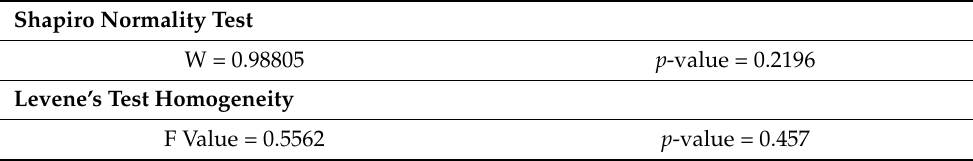
Table 7. Welch Test and Confidence Interval.